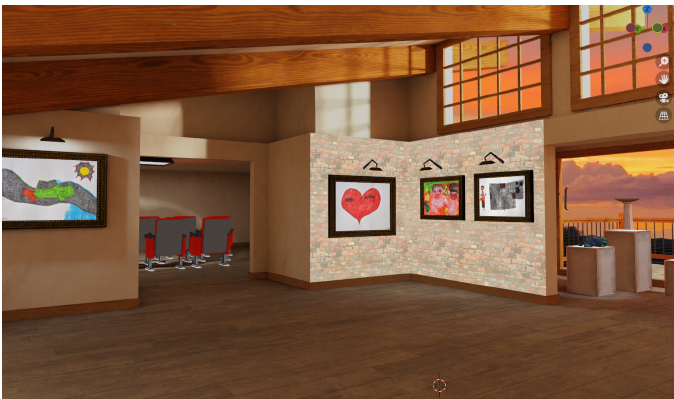
Figure 4. Visualization of the exhibition hall, cinema room, and balcony in